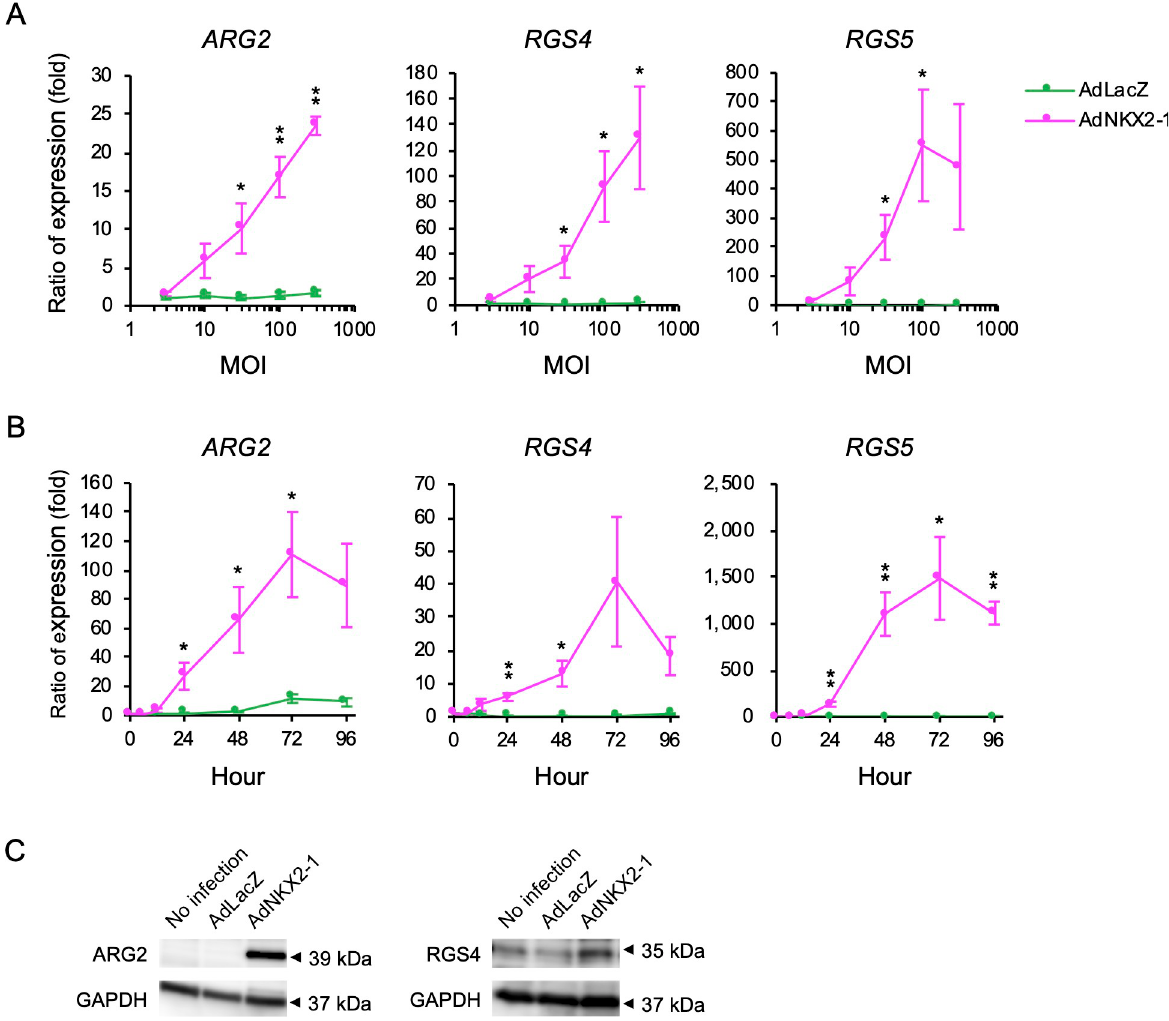
Fig 4. ARG2, RGS4, and RGS5 expression in BHP18-21v cells analyzed using real-time PCR and western blotting. (A) MOI-dependent changes in gene expressions quantified by real-time PCR 72 h after adenoviral vector infection (n = 6). Ratios of gene expressions in infected cells to those in non-infected cells 72 h after infection are shown. (B) Time-dependent changes in gene expressions quantified by real-time PCR after 300 MOI adenoviral vector infection (n = 6). Ratios of gene expressions in infected cells to those in pre-infected cells (0 h) are shown. Error bars indicate SEM. � p < 0.05 and �� p < 0.01, significant differences between AdNKX2-1 and AdLacZ. (C) Western blot showing ARG2 and RGS4 expression 72 h after 300 MOI AdLacZ or AdNKX2-1 infection (upper panel). Loading control, GAPDH expression (bottom